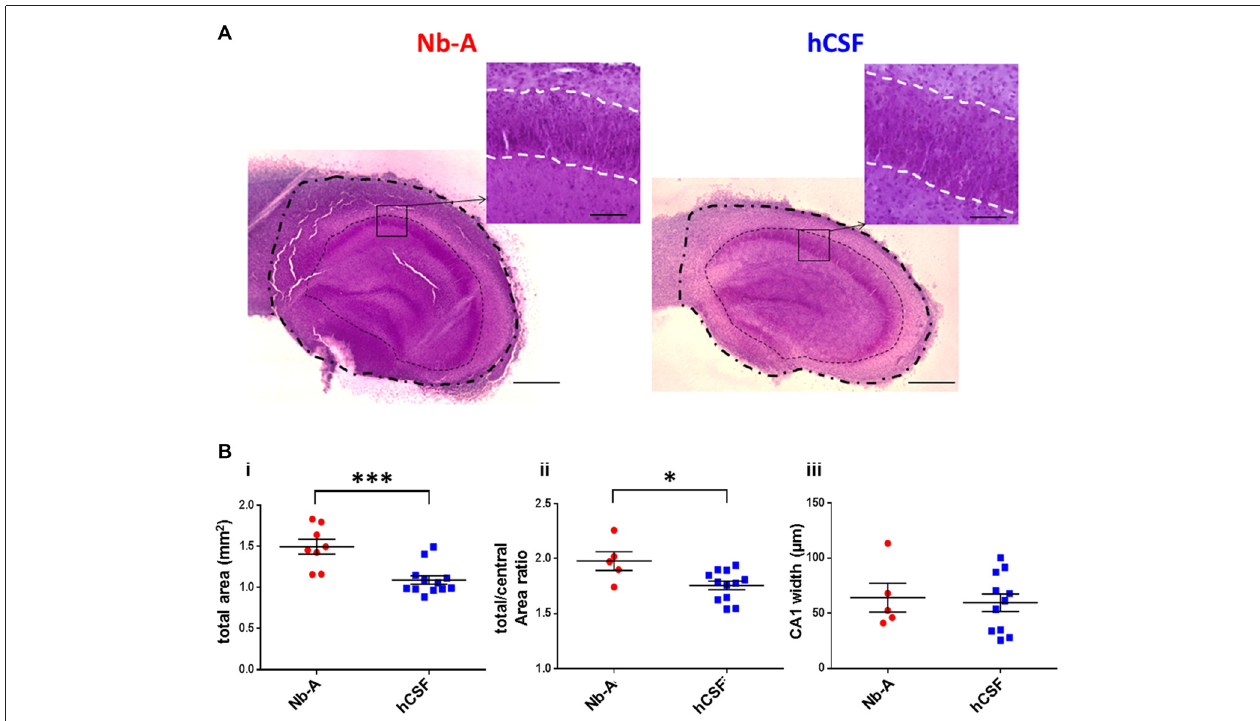
FIGURE 4 | Gross morphology of slice cultures in Neurobasal-A-based medium and in hCSF. (A) Representative images of Nissl stained organotypic hippocampal slices incubated 9 div with Nb-A (left image) and hCSF (right image). The outer dashed/dotted line delineates the border for the total area measurement, and the inner dotted line delineates the border for the central area measurement. Small inserts at higher magnification show the pyramidal cell layer in the CA1 region (str. pyramidale) and which is delineated with a white dashed line. Scale bars 500 and 100 µ m, respectively. (B) Diagrams showing values of the total hippocampal area in mm 2 (i) , total/central area (ii) , and the width of CA1 pyramidal cell body layer (stratum pyramidale) (iii) for organotypic hippocampal slices cultured in Nb-A (red, N = 8) and cultured in hCSF (blue, N = 13). ∗ p < 0.05; ∗∗∗ p <